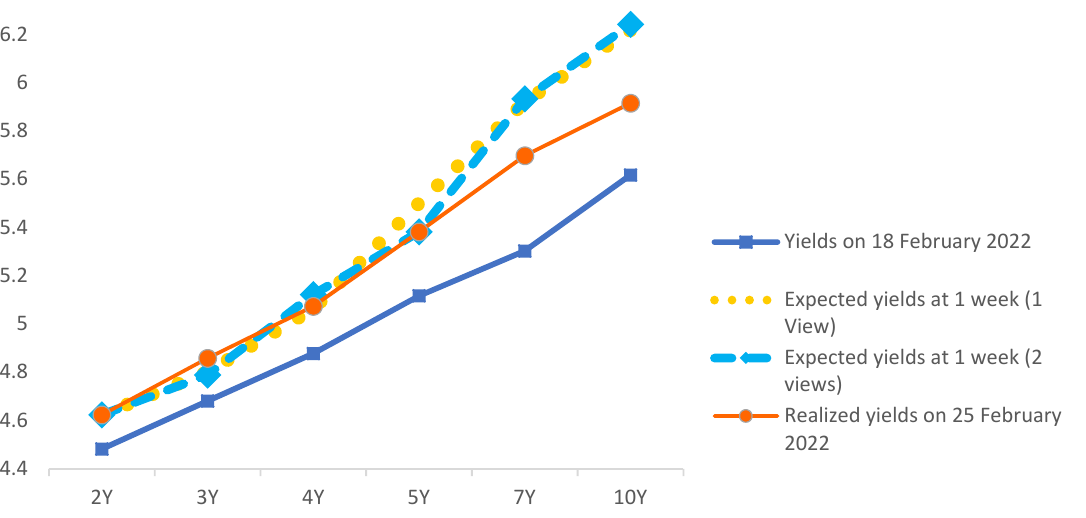
Figure 17. Weekly yield curve forecasts incorporating the trader’s views on 18 February 2022 and realized yields on 25 February 2022. Source: Bloomberg, own computation.